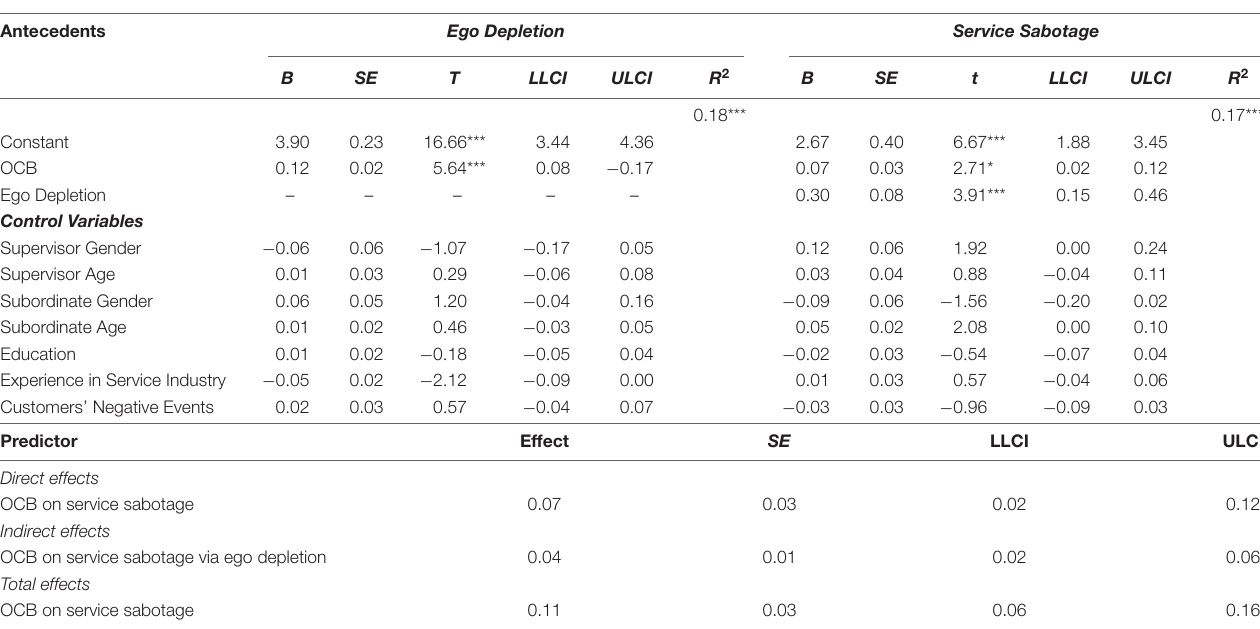
TABLE 2 | Results of mediation